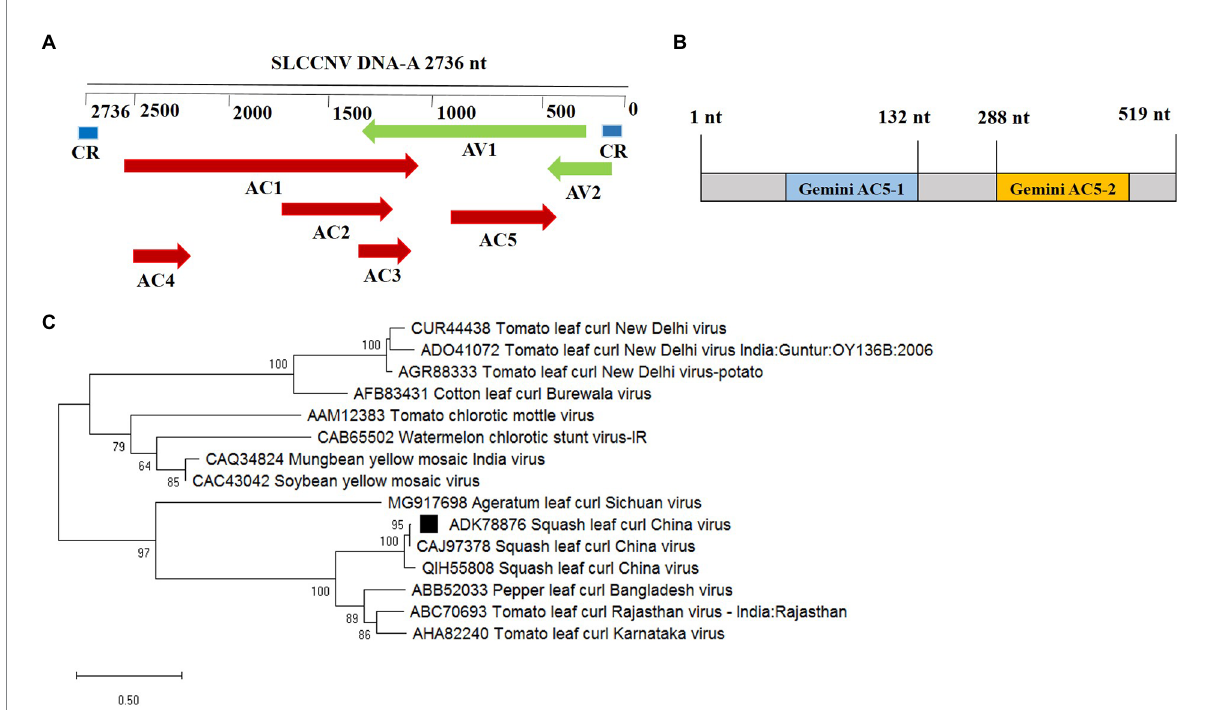
FIGURE 1 Phylogenetic analysis and domain structure of the squash leaf curl China virus (SLCCNV) AC5 protein. (A) The genomic organization of SLCCNV DNA-A. The common region (CR) and all the putative open reading frames (ORFs) located in the viral and complementary strands are indicated. (B) The conserved domain structures Gemini AC5-1 and Gemini AC5-2 were found in SLCCNV AC5 proteins, as determined using the conserved domain database (CDD). Note that the schematic domains of the AC5 protein may not be proportional to the aa scale bar shown at the top because of the varying lengths of the AC5 proteins. (C) Phylogenetic relationships of the AC5 amino acid (aa) sequences of representative begomoviruses. The AC5 aa sequences from begomoviruses were aligned using the Neighbor-Joining method in the MEGA6 program with 1,000 replications. Hides values were lower than